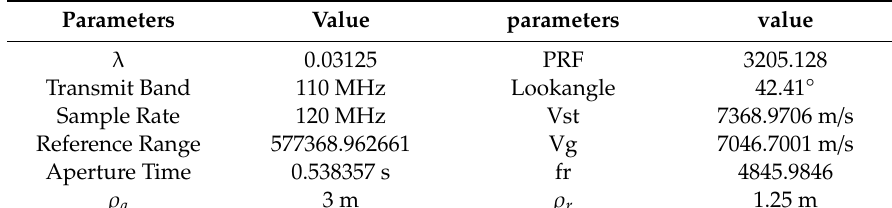
Table 2. Simulation radar parameters.